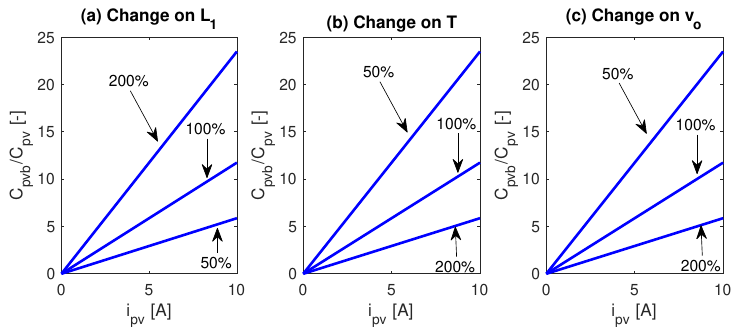
Figure 6. Input capacitor comparison between both buck